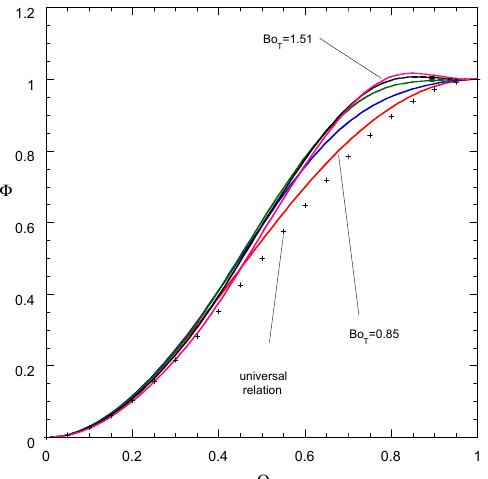
Figure 7. Normalized contact angle versus normalized azimuthal angle for the cases presented in Figure 5. The variable Bo T for the three intermediate curves is 1.03, 1.3, 1.43, respectively (from lower to higher). The universal relation proposed in [13] is also shown.